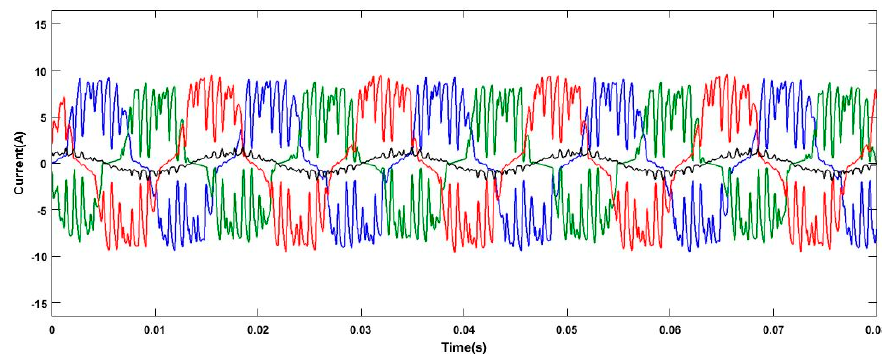
Figure 6. Source current without SAPF compensation for case 1.